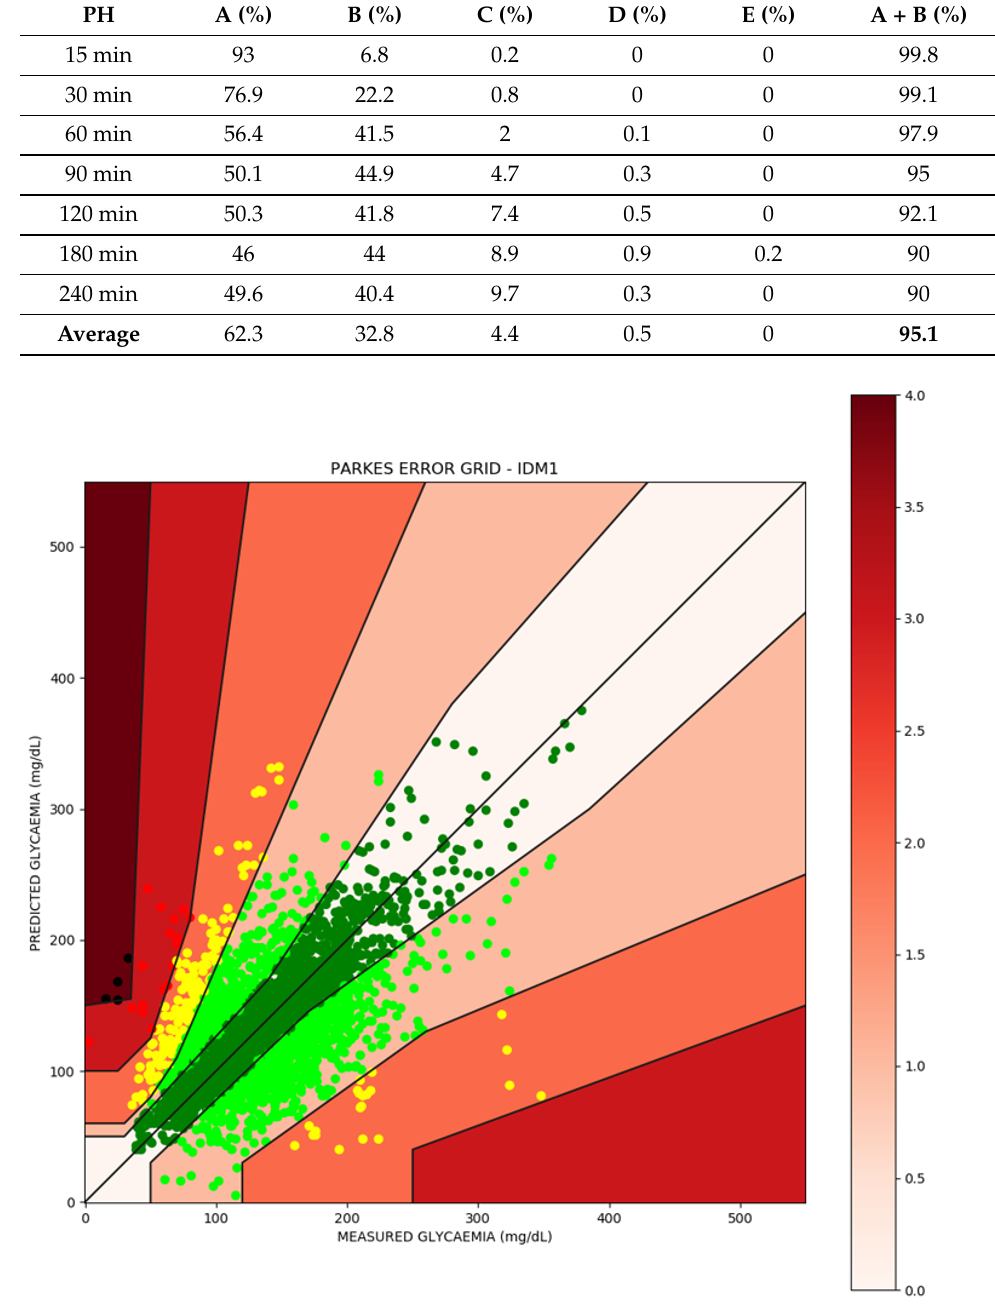
Figure 7. PEG (daytime period) for seven T1D individuals. Green dots lay at zones A and B (95.1% on average): 3804